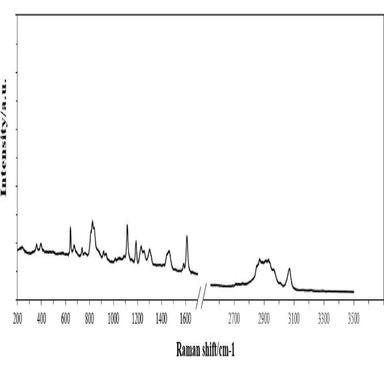
Typical Raman spectrum with several phases located in the crack samples with: (a) 0% CA, (b) 1% CA, and (c) 2% CA.